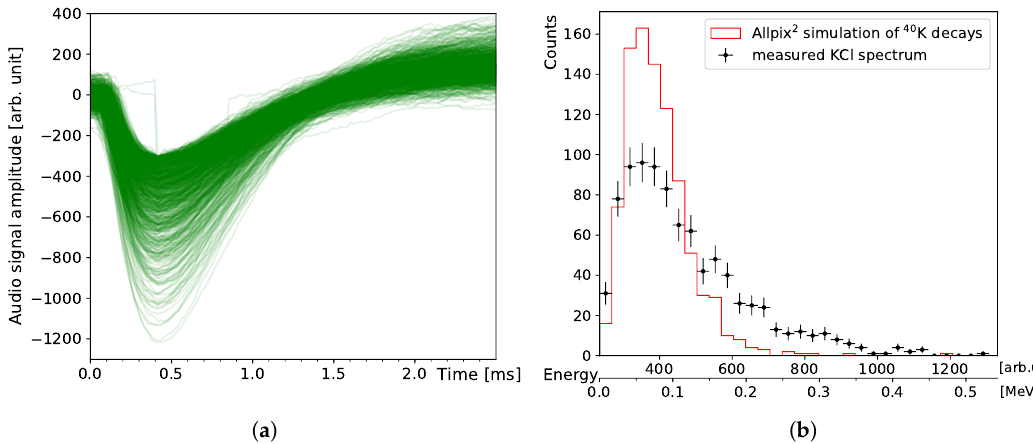
Figure 7. Measurement and simulation of the DIY particle detector response to KCl: ( a ) The negative component of the circuit ouput pulses is ≈ 1 ms wide, the amplitudes are proportional to the energy deposited by ionising radiation. Two pulses are truncated (sharp vertical edges) due to incomplete sampling. ( b ) Histogram of the pulse amplitudes recorded in Figure ( a ), including energy calibration on the lower x-axis. The red line shows a simulation for the same number of decays from pure 40